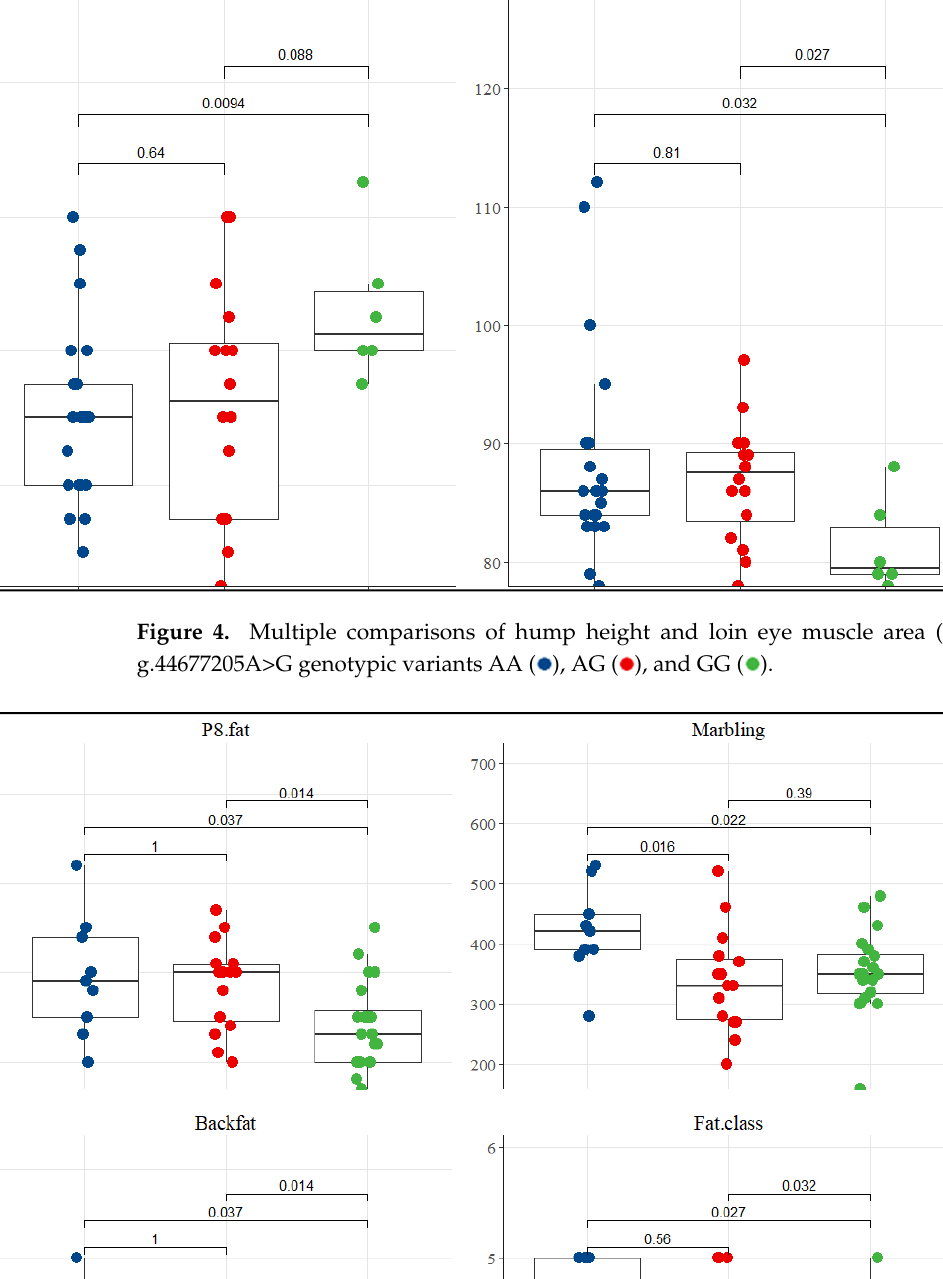
Figure 4. Multiple comparisons of hump height and loin eye muscle area (EMA) for FABP4